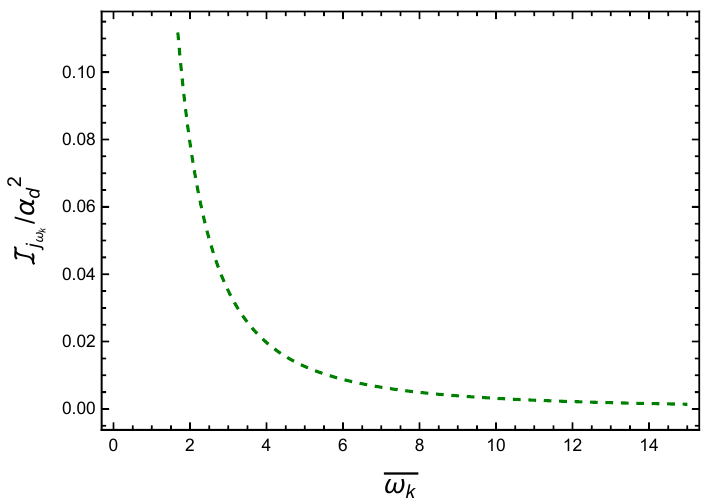
, signifying the concurrence, is plotted for two outgoing null Figure 21 . The quantity I j /α 2 d ωk detectors in a (1 + 3) dimensional de Sitter spacetime with respect to the dimensionless frequency of the field ω = ω for fixed ∆ E = 0 . 5 . We considered k k k α d d/α d